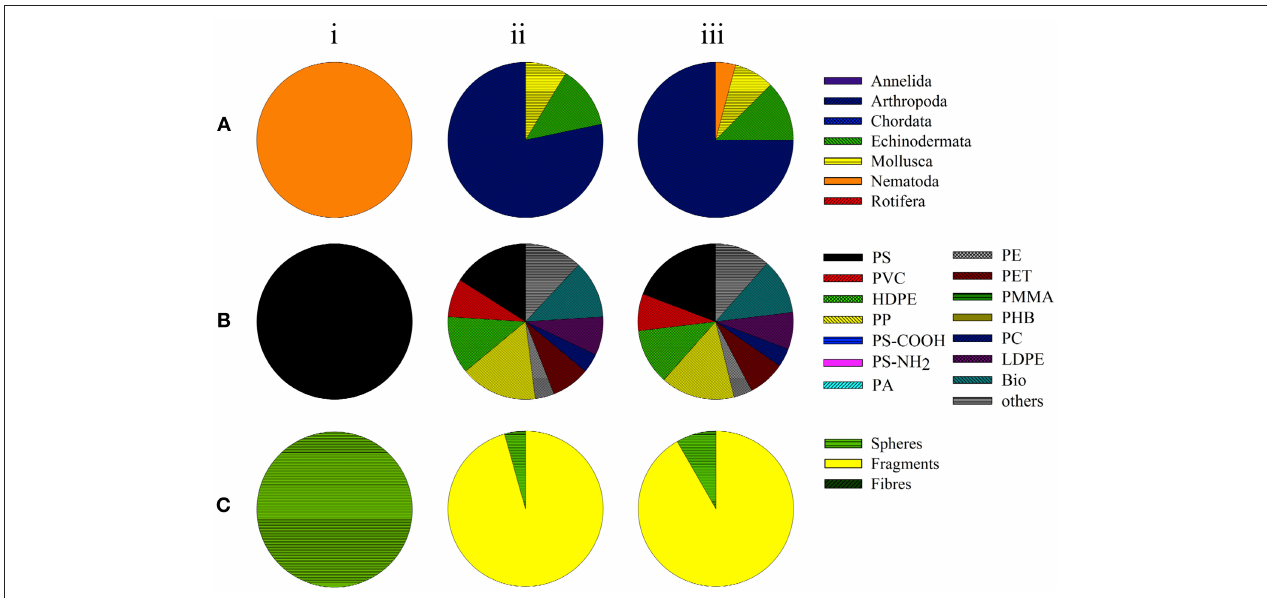
FIGURE 3 | Toxicity assays examining chemical effects by leachates of plastic particles in organisms in (i) freshwater studies, (ii) marine studies, and (iii) total. Data depict the groups of organisms (taxa) used (A) , polymer types (B) , and shape of small-scale plastic particles applied (C) .